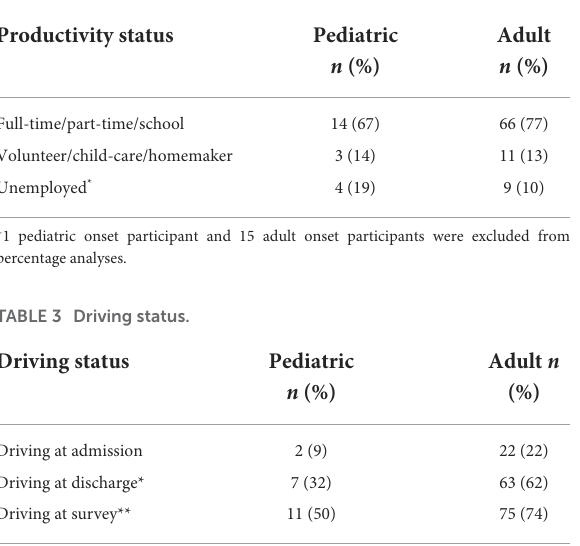
TABLE 2 Productivity status at follow-up.